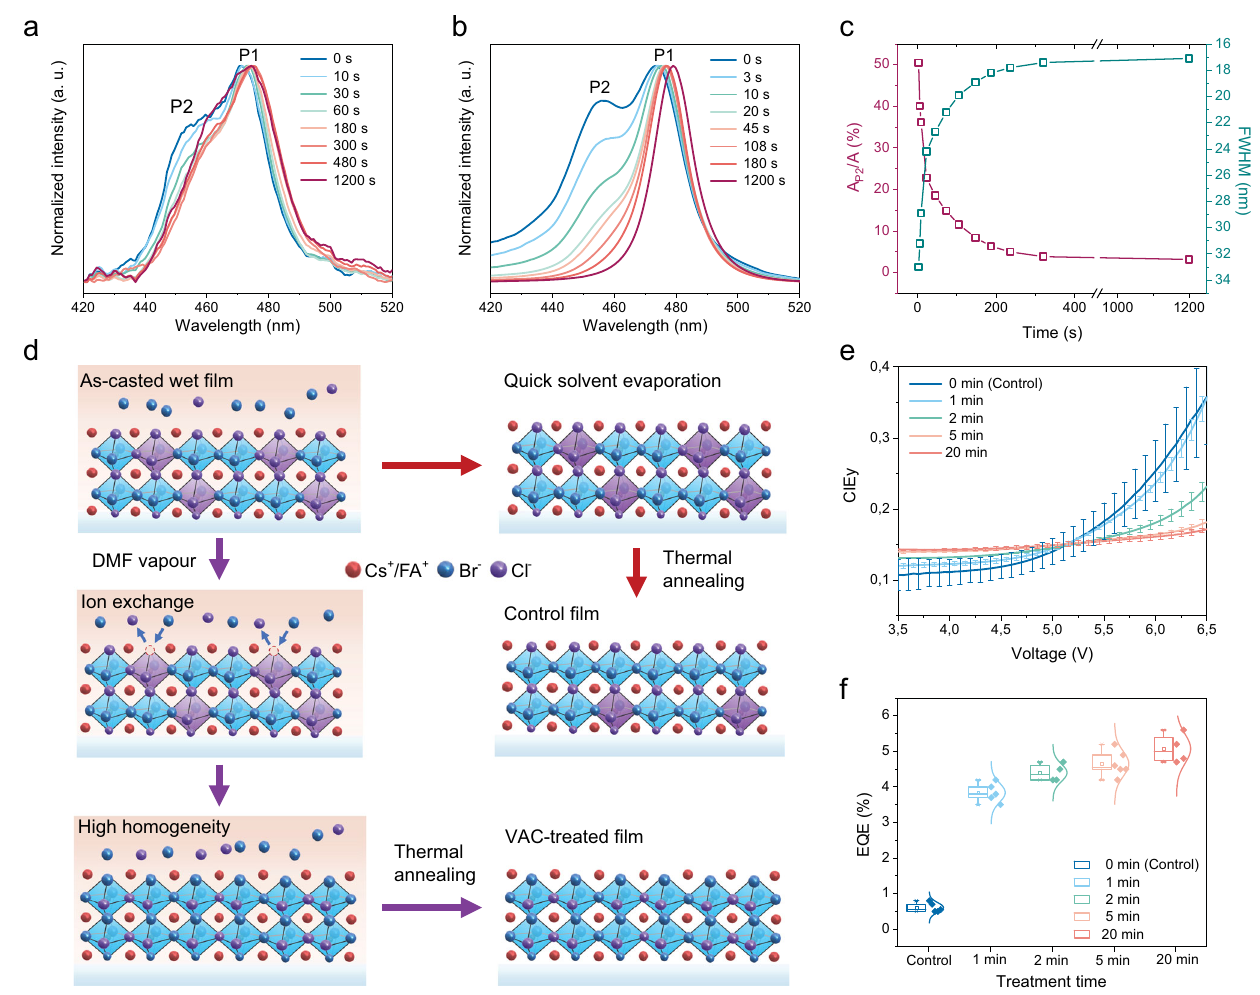
Fig. 3 Understanding the halide redistribution during VAC-process. a, b PL evolution of the precursor fi lms kept in the glovebox atmosphere ( a ) and DMF atmosphere ( b ) with time. c the evolution of emission linewidth and the proportion of P2 (A P2 ) to the respective total area of the emission band (A) in VAC-treated fi lms with time. d Schematic illustration of the proposed mechanism for halide redistribution. Here, the purple Pb(Br/Cl) 6 4 − octahedra represent chloride-rich phases in respect to that with stoichiometric bromide/chloride distribution (blue octahedra). The khaki represents the liquid phase within the fi lms and the blue arrows represent ion exchange process. The excessive ions within the dried fi lms are not illustrated for clarity. e , f The evolution of CIE coordinates upon bias ( e ) and peak EQEs of the devices with varying duration of VAC-treatment (0, 1, 2, 5, 20 min). f The error bars present the standard deviation extracted from 4 to 6